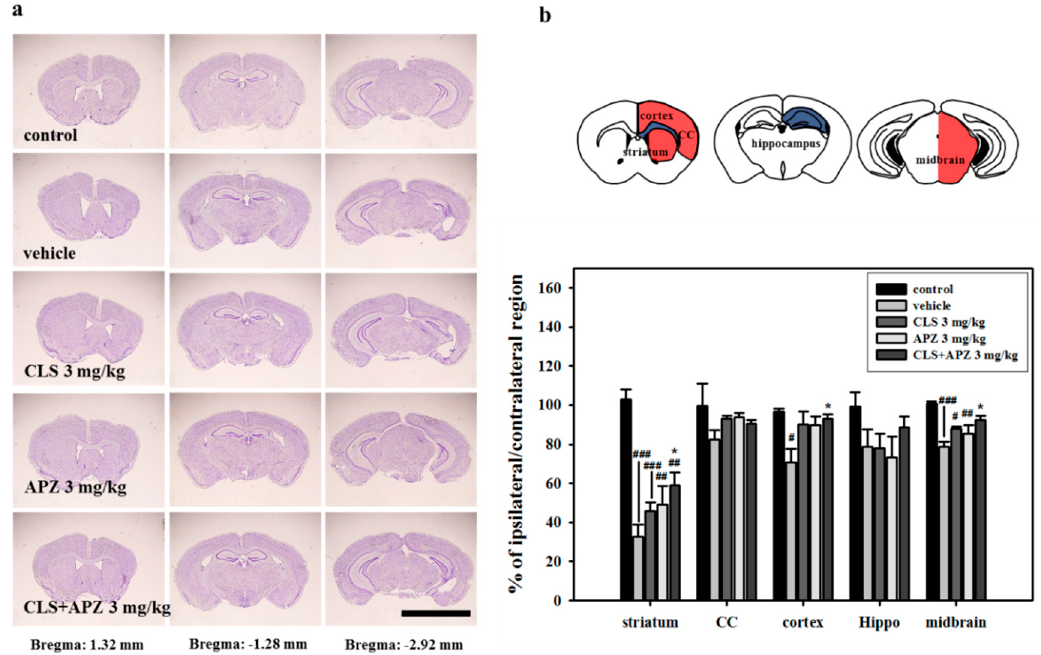
Figure 2. Comparison of ipsilateral/contralateral atrophy volume in each brain region. Photomicrograph ( a , cresyl violet stain) and its histogram ( b ) for histological analysis ( n = 5). Schematic diagram ( b ) shows the regions of the striatum, corpus callosum, cortex, hippocampus, and midbrain of the brain. Each region was located at 1.32, − 1.28, and − 2.92 mm from the bregma. The combined use of APZ and CLS resulted in significantly ameliorated atrophy changes of the ipsilateral striatum, cortex and midbrain compared to vehicle-treated mice. CC, corpus callosum; hippo, hippocampus. # p < 0.05, ## p < 0.01 and ### p < 0.001 versus control mice; * p < 0.05 versus vehicle-treated mice; scale bars = 5 mm.